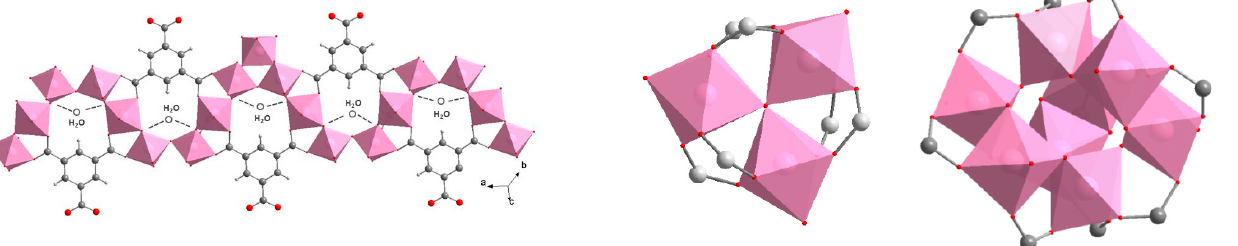
Figure 9. Presentation of the inorganic chain and hydrogen bonds in MIL-96(Al) 24 ( left ), trimers in MIL-100(Al) ( middle ) and octanuclear clusters in MIL-110(Al) ( right ). AlO 6 octahedra are rose, C atoms grey, O atoms red and H atoms light grey. Structures are drawn from the cif-files by using DIAMOND software [46].